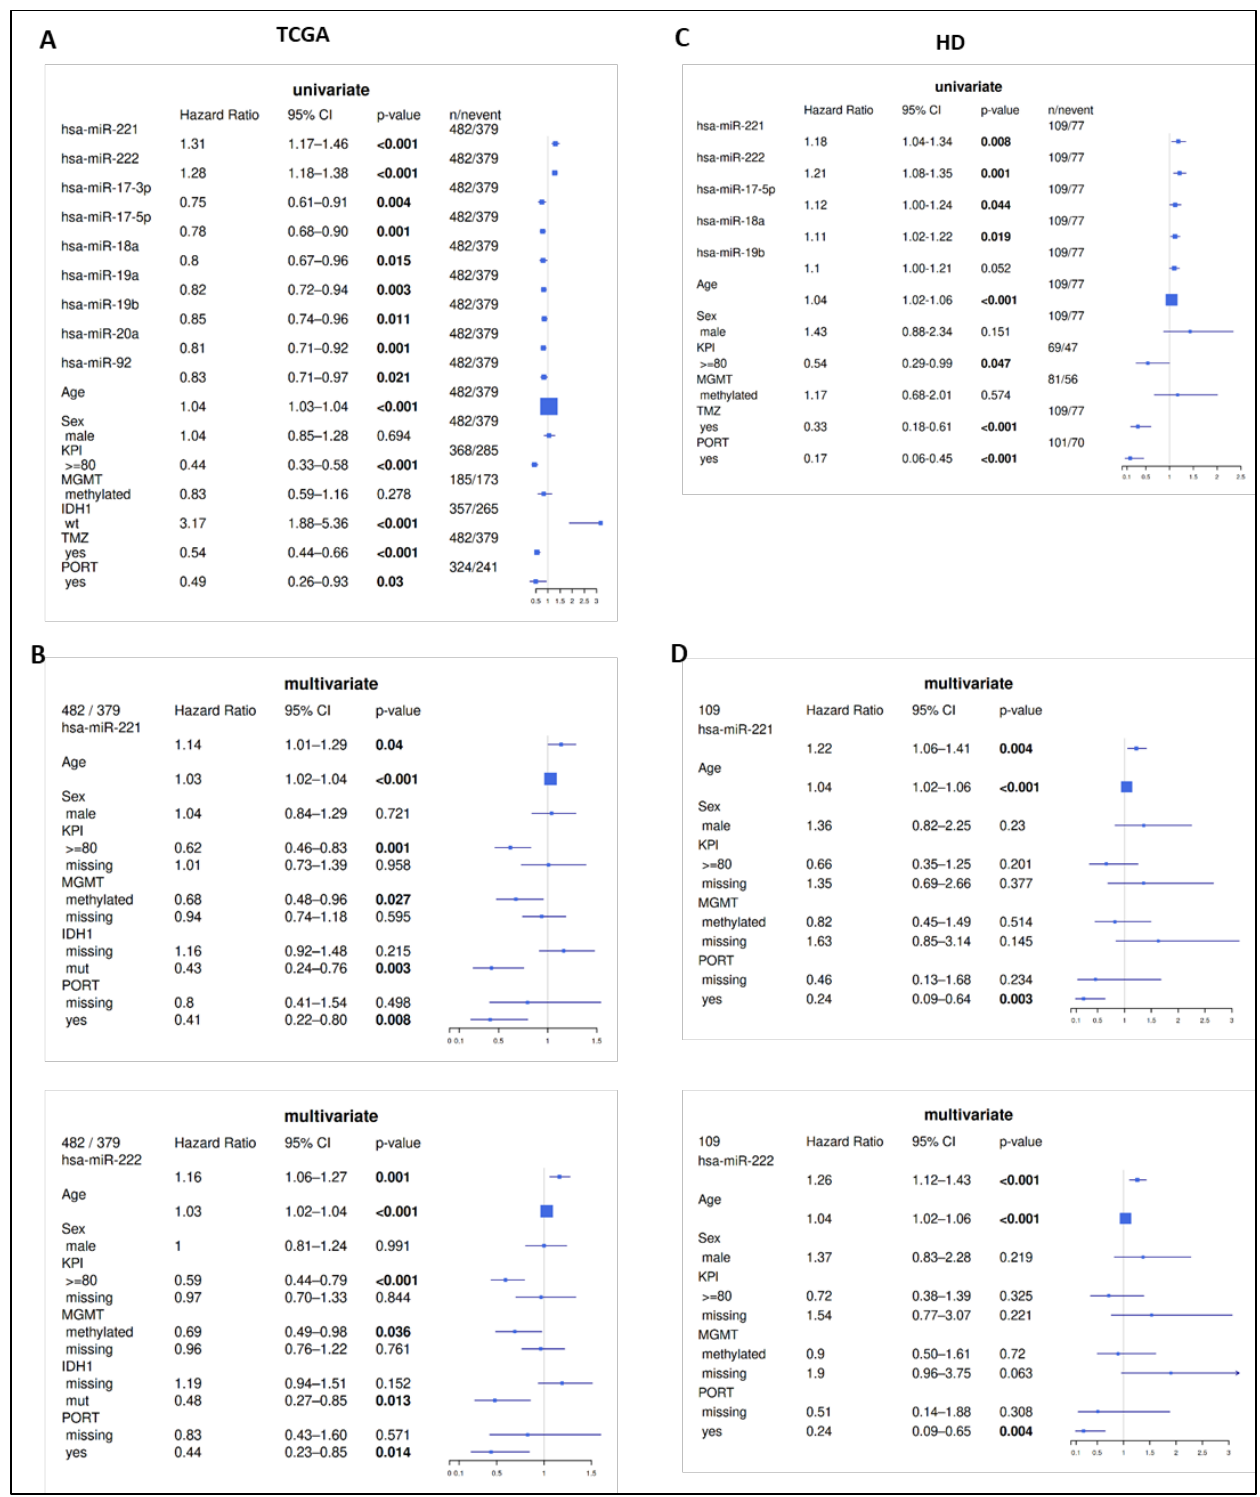
Figure 1. Uni- and multivariate analyses of miR expression for OS. Univariate analyses show a negative prognostic value for miR-221/222 (( A ) TCGA and ( C ) HD). Multivariate analyses confirm their prognostic value ( B , D ). For members of the miR-17-92 cluster, a positive prognostic value was observed in the TCGA cohort ( A ); in HD, an unfavorable prognosis was found ( C ). Bold font indicates p -value ≤ 0.05(Cox proportional hazard models, HR: hazard ratio; CI: confidence inter- val).